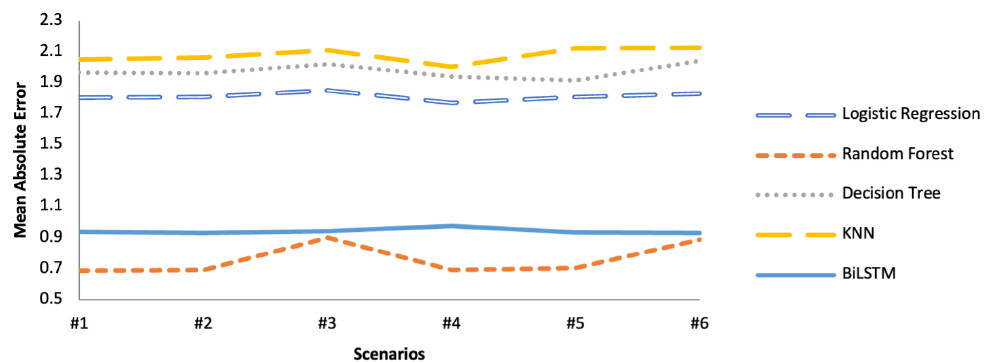
Figure 8. Algorithms’ Mean Absolute Error for the regression method (Y = “Rating”).